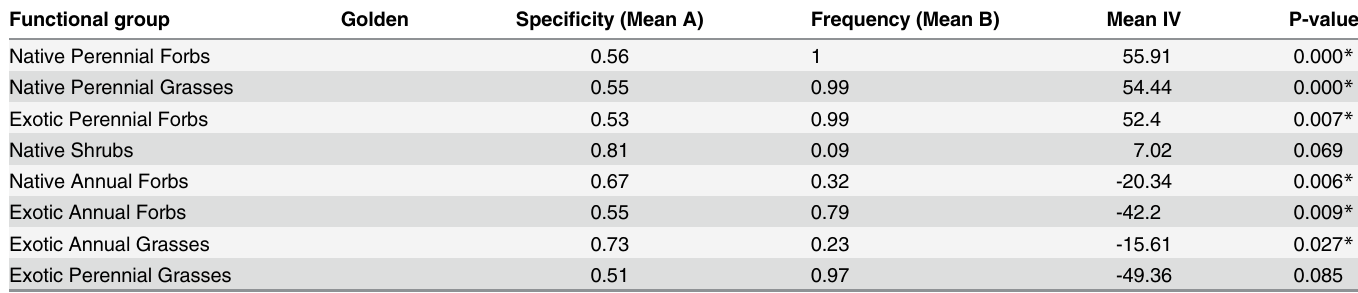
Table 3. Indicator Values of Golden Paintbrush by Plant Functional Group.